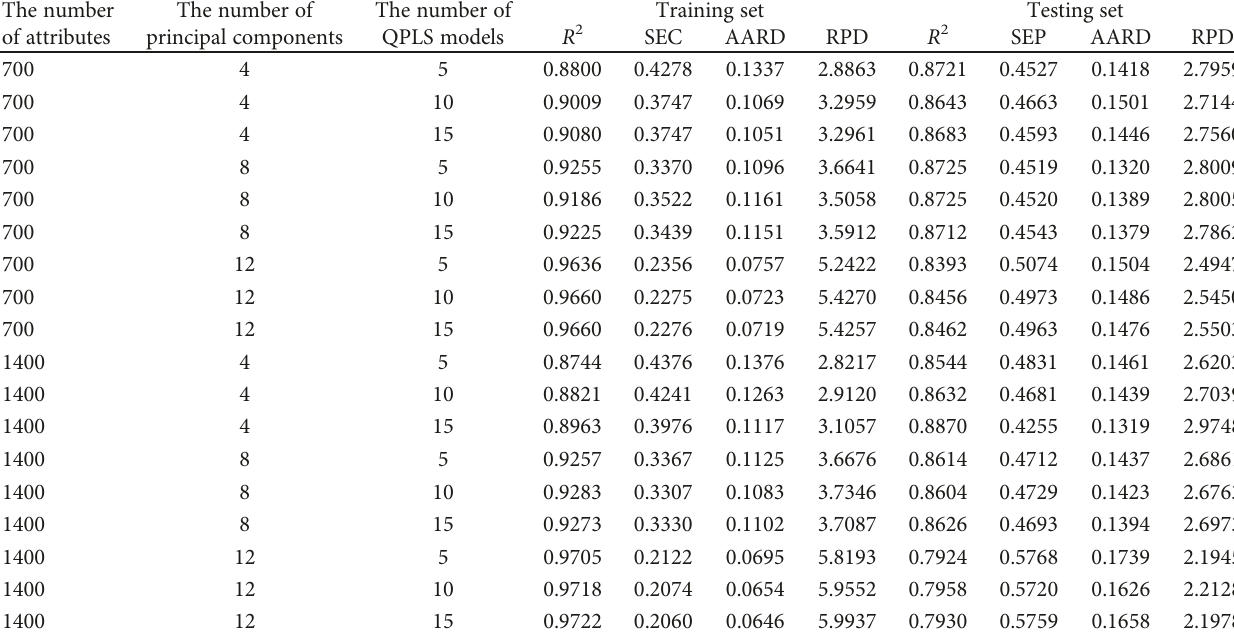
Table 4: The results of the k QPLS-SVR models for quanti fi cation of the relative content of Pst DNA in wheat leaves in the incubation period built when SNV was used as the preprocessing method of the original near-infrared spectra. The number The number of The number of attributes principal components